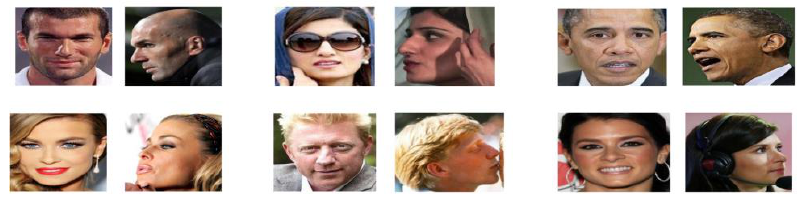
Figure 13. Example images from the CFP (celebrities in frontal-profile) dataset.